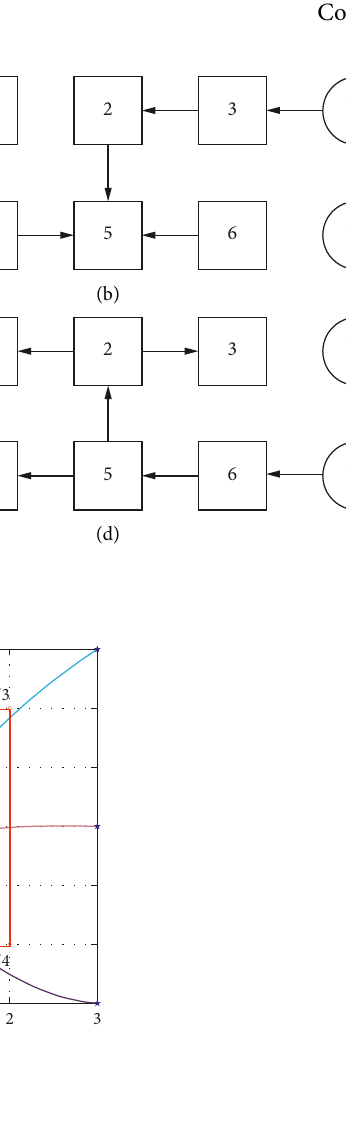
Figure 2: Position of followers.